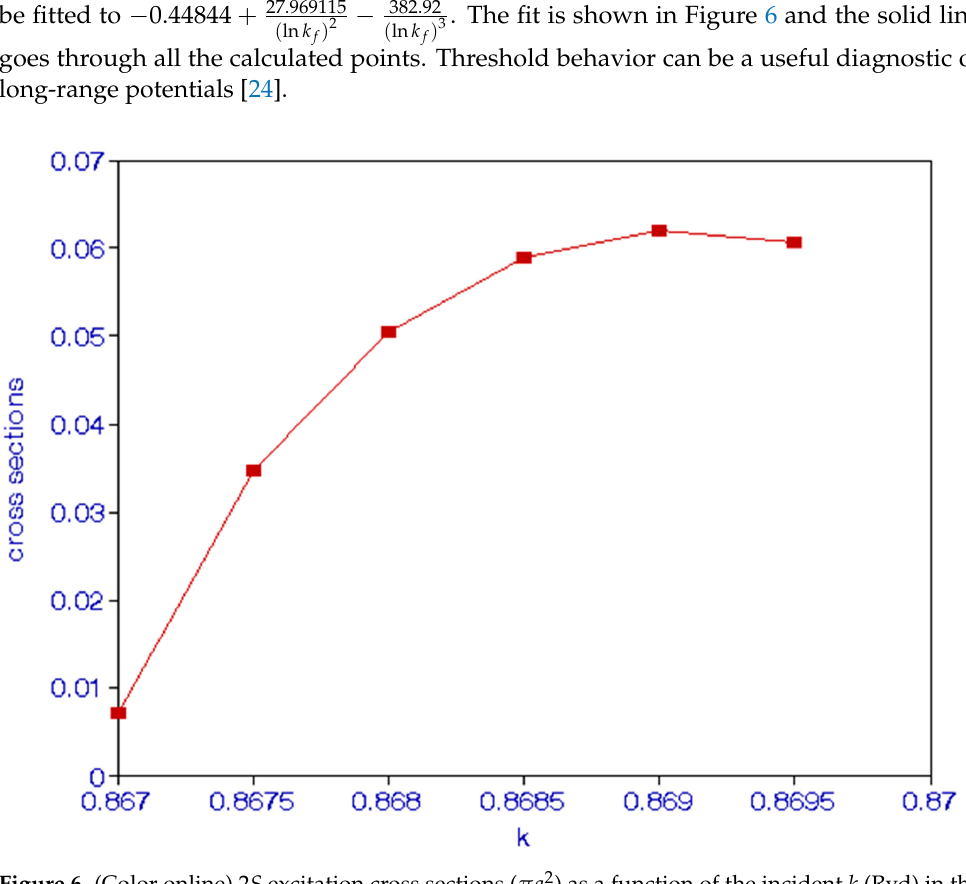
Figure 6. (Color online) 2 S excitation cross sections ( π a 2 0 ) as a function of the incident k (Ryd) in the threshold region, the solid line represents the fit to the squares (calculated cross sections).